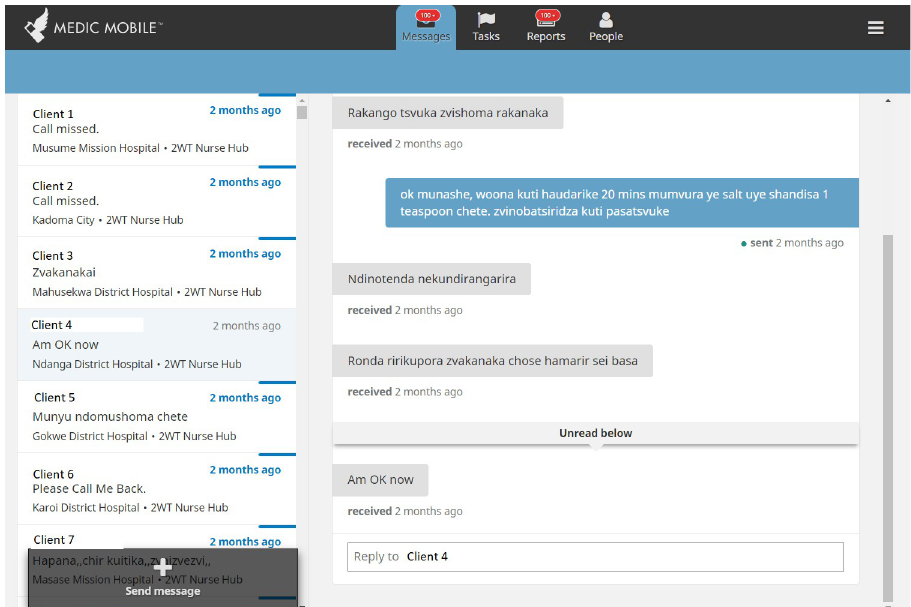
Fig 2. CHT “Messages Tab”. This 2wT tab provides an interface for interactive SMS between 2wT patients and providers on the PC or mobile (tablet or phone) app.